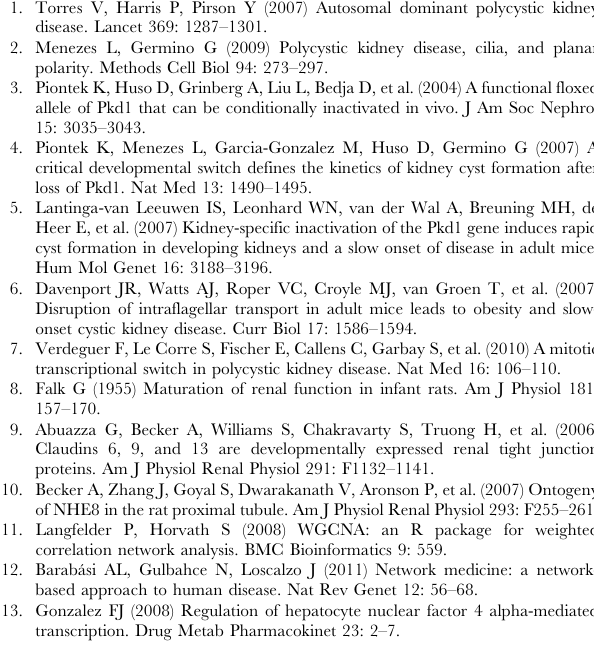
Table S11 Gene Ontology Biological Processes classification of genes in Module 5 of the meta-analysis. (XLS) Table S12 Gene Ontology Biological Processes classification of genes in Module 17 of the meta-analysis. Table S13 Differentially detected mass spectra in the positive electrospray ionization mode. Table S14 Differentially detected mass spectra in the negative electrospray ionization mode. Table S15 Differentially detected mass spectra with putative KEGG ids in KEGG Pathways. Table S16 Differentially detected metabolites in each of the significant pathways.